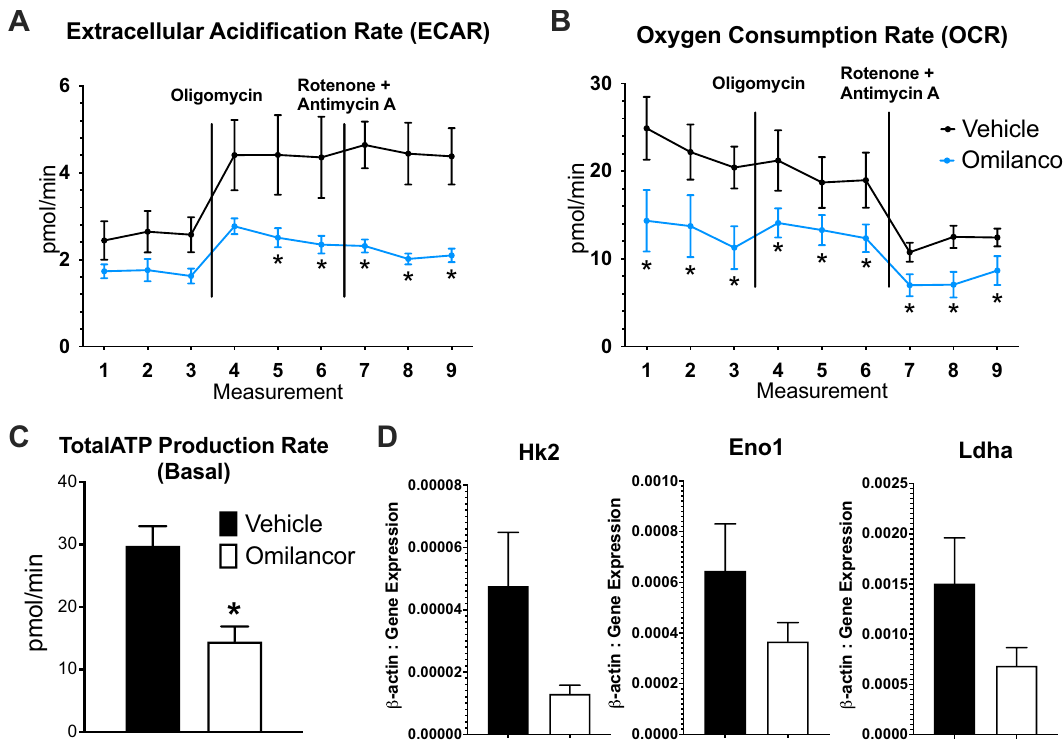
Figure 5. Metabolic effects of in vivo topical omilancor treatment in psoriatic keratinocytes. KC from vehicle- and omilancor-treated mice were isolated at day 7 post IMQ-challenge. ECAR ( A ), OCR ( B ) and total ATP production ( C ) were assessed using Agilent Seahorse instrument. Hk2 , Eno1 and Ldha expression was quantified by qRT-PCR in dorsal skin ( D ). * P ≤